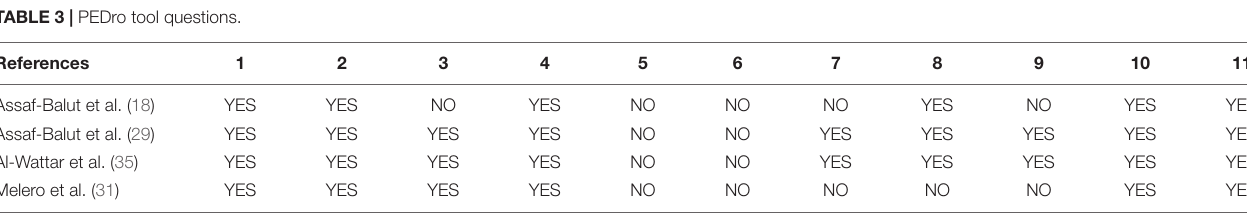
TABLE 3 | PEDro tool